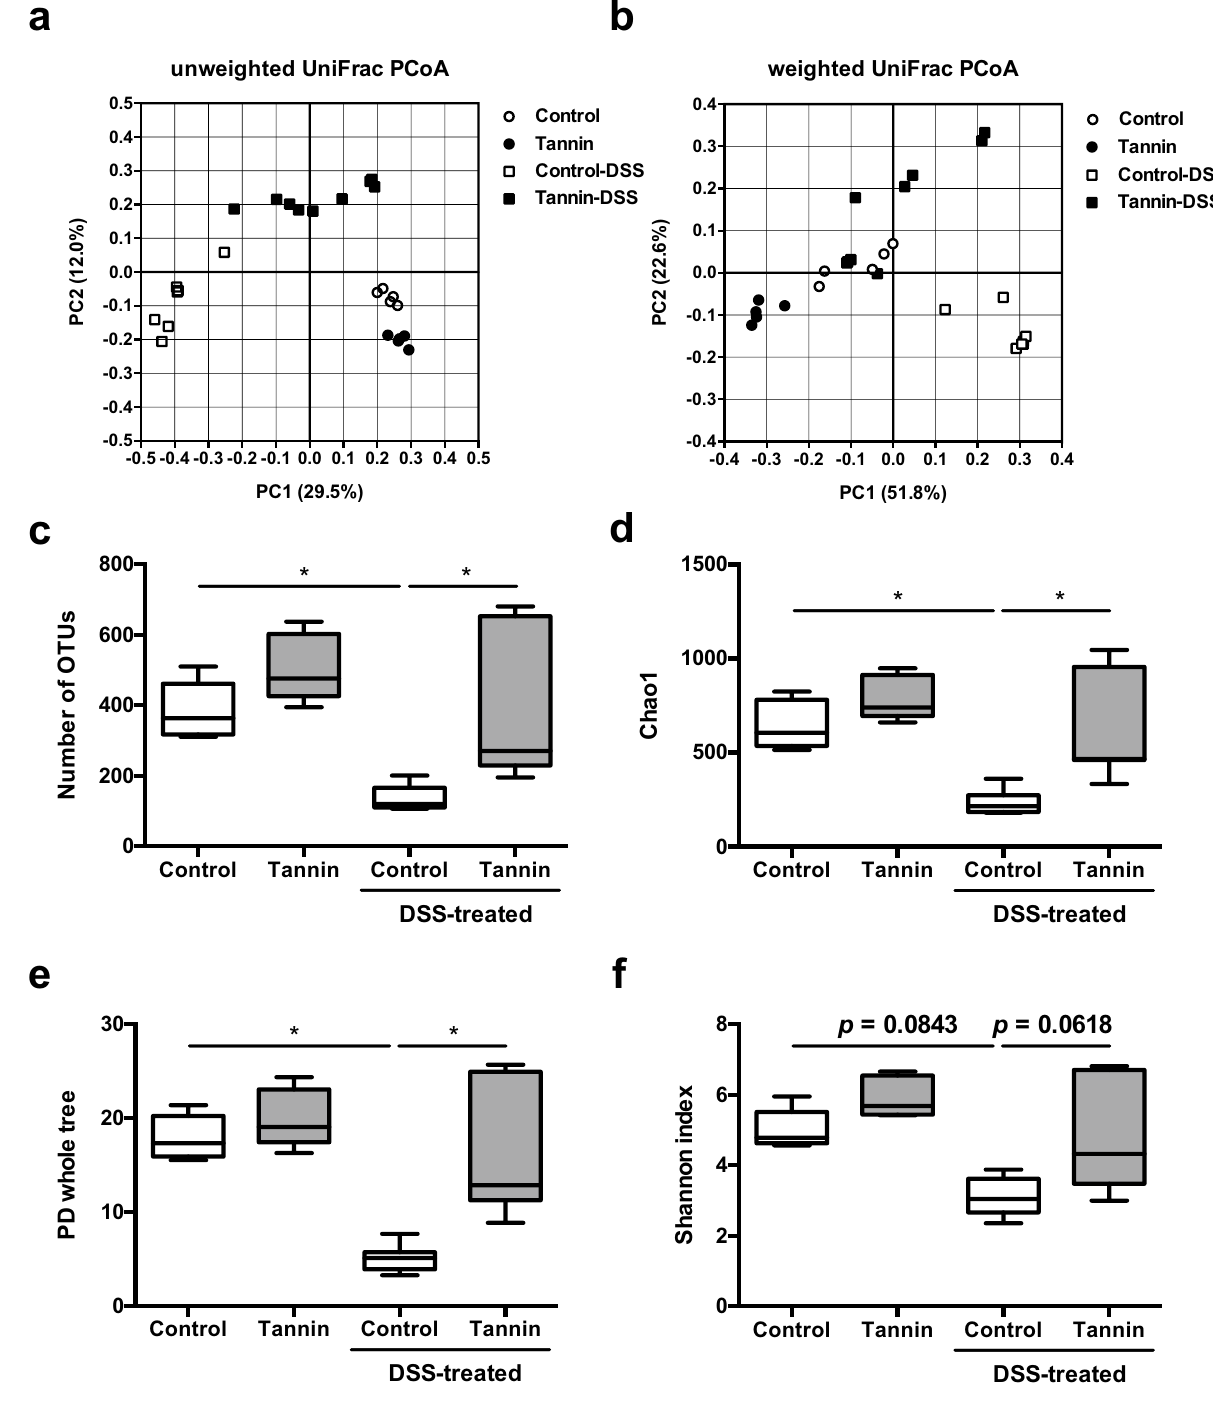
Figure 4. Dietary supplementation of persimmon-derived tannin affects the composition and diversity of microbiota in colitis-induced mice. Compositions of faecal bacteria in untreated and DSS-treated mice fed the control or tannin-supplemented diet were analysed by 16S ribosomal RNA gene sequencing. ( a , b ) PCoA of unweighted ( a ) and weighted ( b ) UniFrac distances were plotted. ( c – f ) Alpha-diversity indices, number of OTUs ( c ), Chao1 ( d ), PD whole tree ( e ), and Shannon index ( f ) were calculated by QIIME software. Data are shown as the mean ± SEM with individual plots. Untreated mice fed the control diet (n = 5) or tannin diet (n = 5); DSS- treated mice fed the control diet (n = 7) or tannin diet (n = 9). * p <